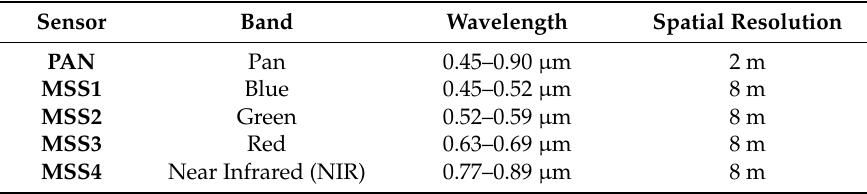
Table 1. Parameters of GF-1 satellite